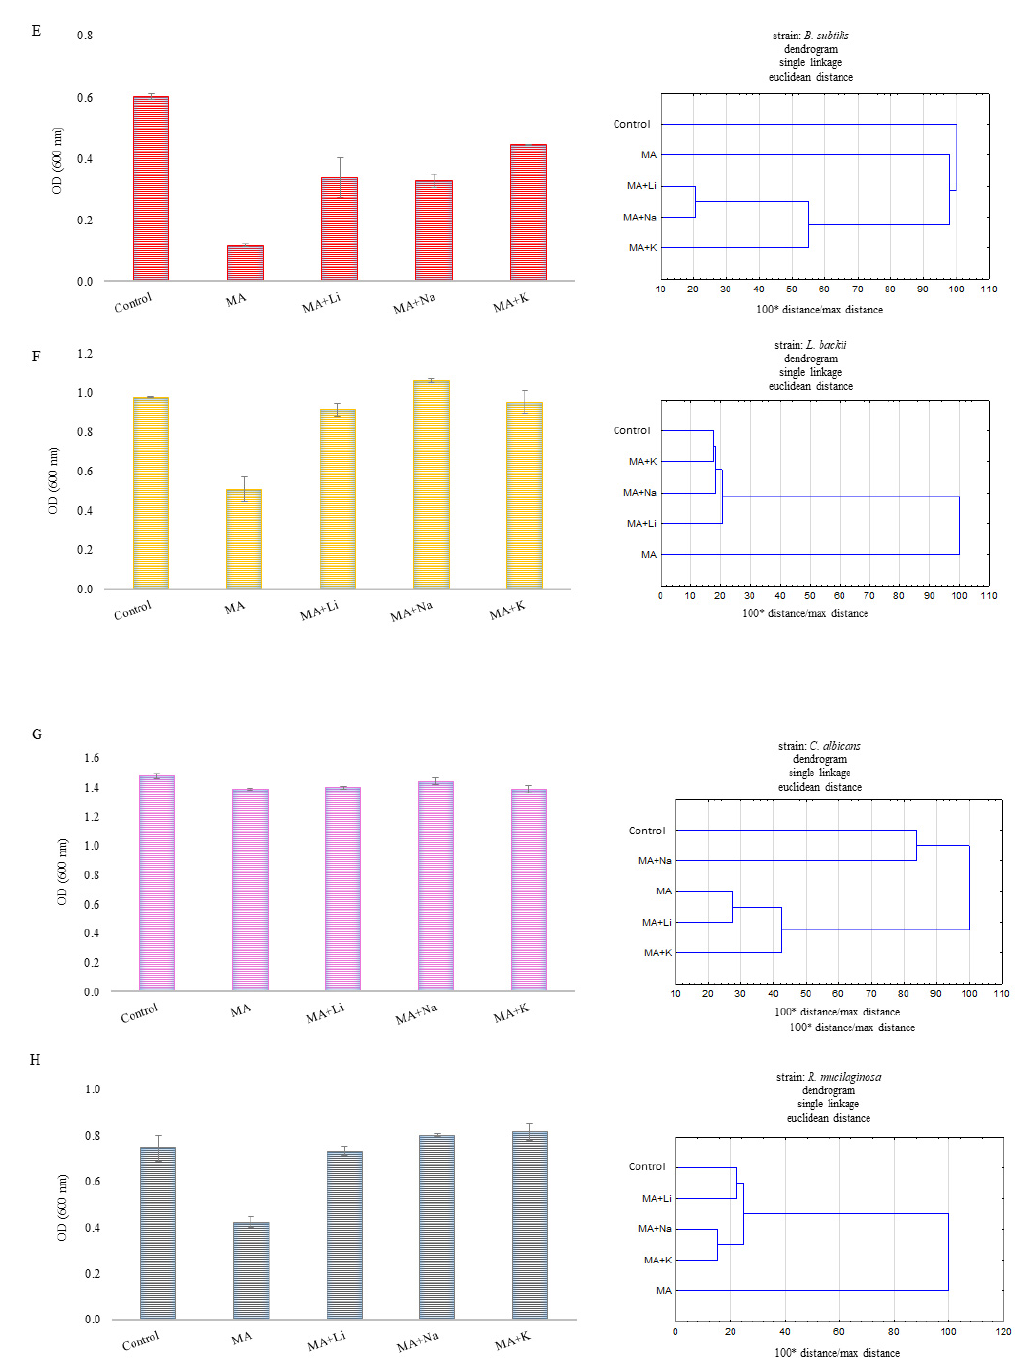
Figure 7. OD value on the last day of cultivation using Bioscreen C Pro (left) and dendrograms (right) for ( A ) L. monocytogenes ATCC 13932, ( B ) S. aureus ATCC 25923, ( C ) E. coli ATCC 25922, ( D ) S. typhimurium ATCC 14028, ( E ) B. subtilis ATCC 6633, ( F ) L. backii KKP 3566, ( G ) C. albicans ATCC 10231, and ( H ) R. mucilaginosa KKP 3560 in the presence of MA (5 mg/mL) and its salts (5 mg/mL). Control means the strain without any antimicrobial agent.